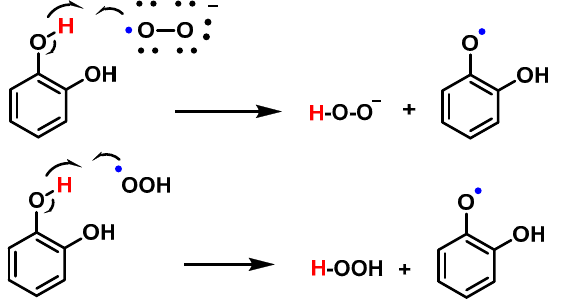
Figure 59. The reaction of QH2 with HO 2• and O 2•– provides radical semiquinone.